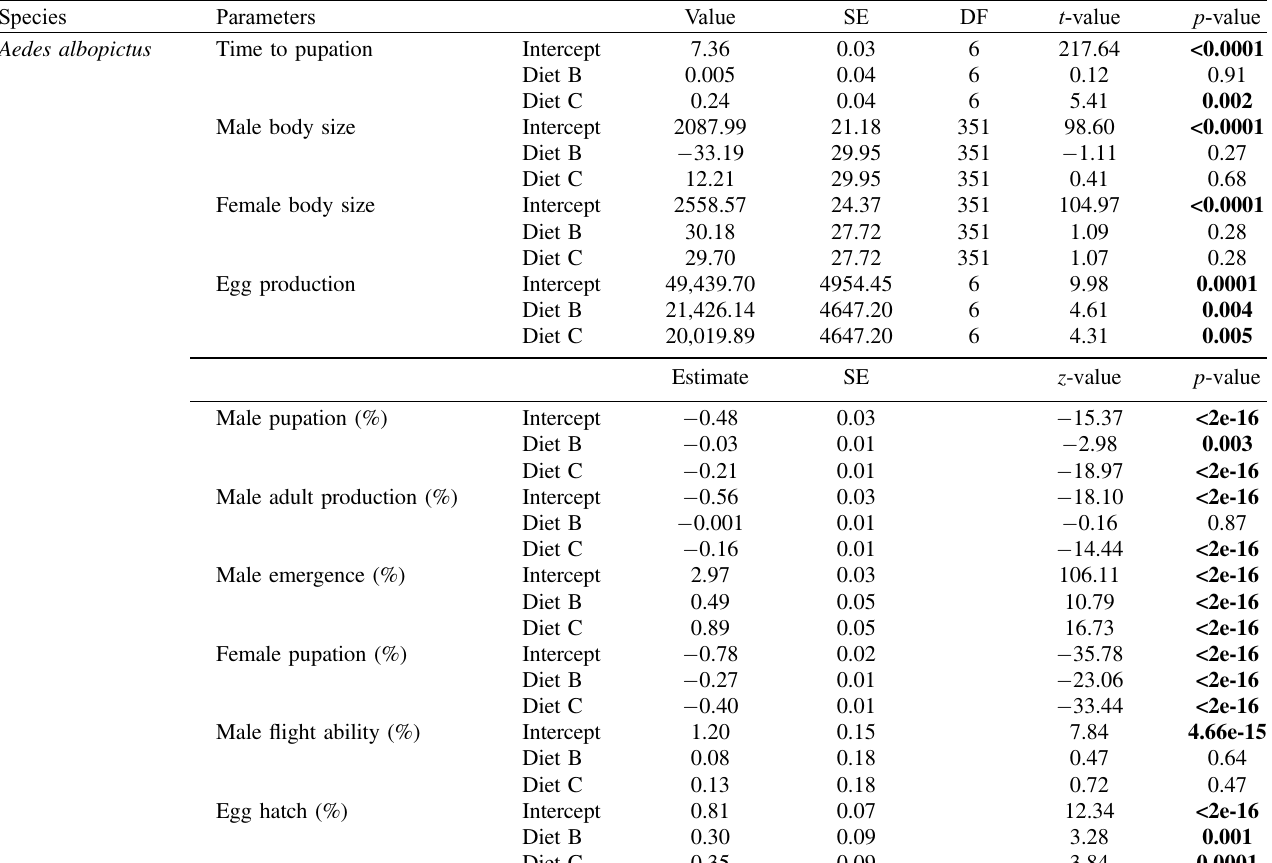
Table 5. Results of the linear mixed model and binomial generalized linear mixed model for the effect of diet mixtures on Aedes albopictus life history trait parameters. Values were compared to reference diet